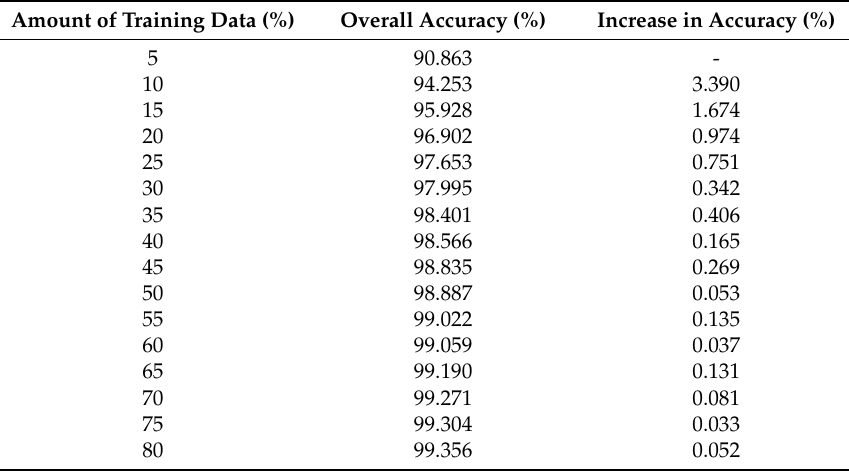
Table 6. Increase in accuracy with amount of training